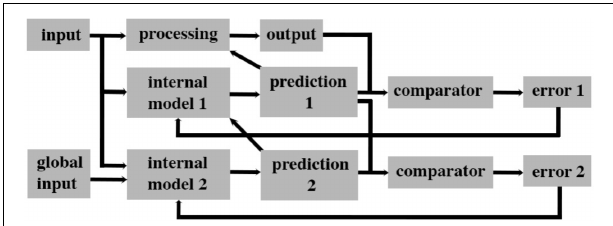
FIGURE 4 | A parallel forward models algorithm that generates levels of awareness within a system. This scheme is based on the concept that a system that can accurately predict its future state based on its current state has awareness that is functionally significant for the system. This form of awareness is postulated to be necessary but not sufficient for subjective experiences such as pain. This algorithm processes input simultaneously along three parallel streams. The base level is the processing module that creates an output for the system. A second level consists of a module that creates a simplified model of the base level processing that predicts (predictions 1) the future output of the system. That prediction is then compared to the actual output in a separate module (comparator) and the error generated is used to adjust the internal model 1 to better predict future states (by attempting to reduce error 1 to zero). A second internal model (internal model 2) uses both the input to the system and available inputs from other systems to predict the outputs of internal model 1. Prediction 2 is feedback into internal model 1 to facilitate a rapid and accurate prediction 1. Prediction 1 likewise feeds back on to base level processing to control its